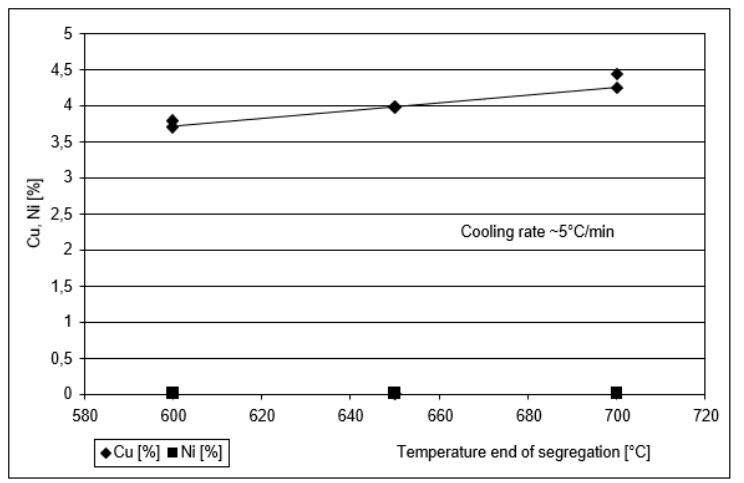
Figure 6. Final copper and nickel contents in PbSn composite as a function of casting